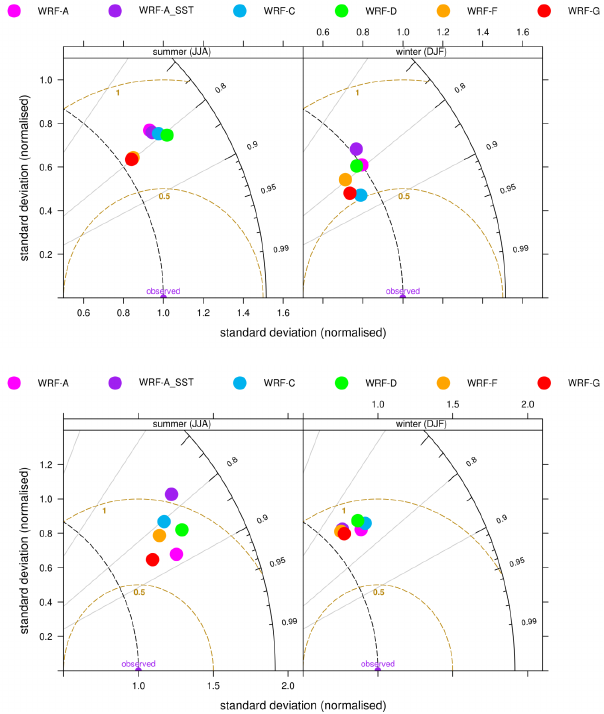
Figure 5. Temporal (upper panel) and spatial (bottom panel) Taylor Figure 5 Temporal (upper panel) and spatial (bottom panel) Taylor plots for precipitation 3 plots for precipitation averaged over Europe for summer and winter averaged over Europe for summer and winter 1990-2008. Updated plot 4